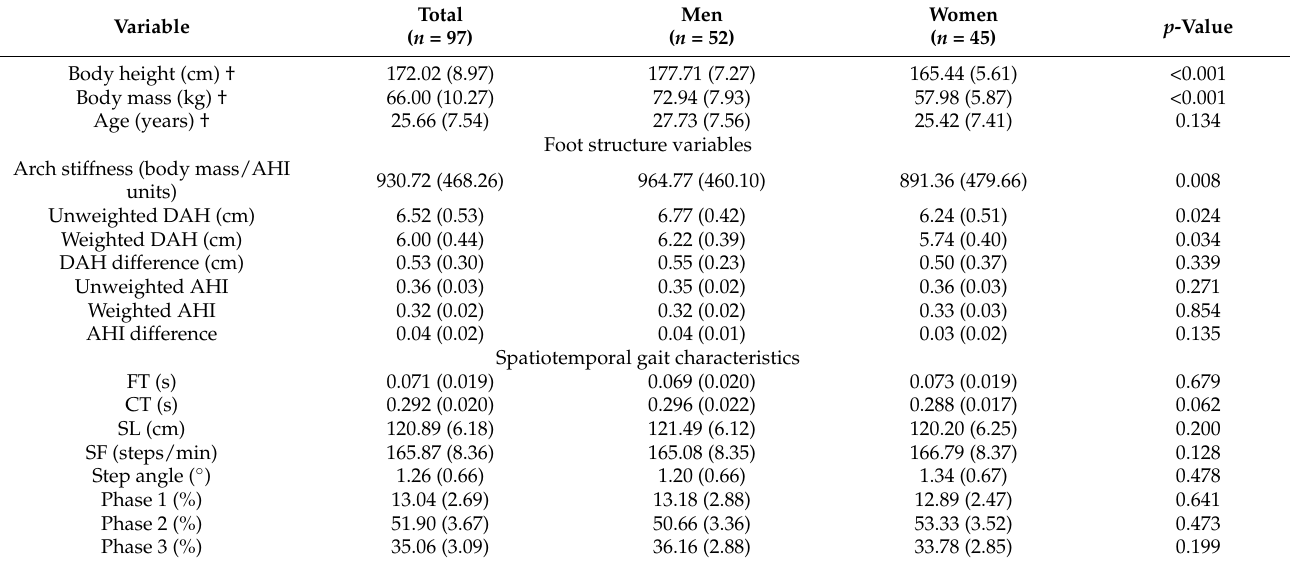
Table 1. Sex comparison in outcome variables (anthropometric, foot structure, and spatiotemporal parameters) .